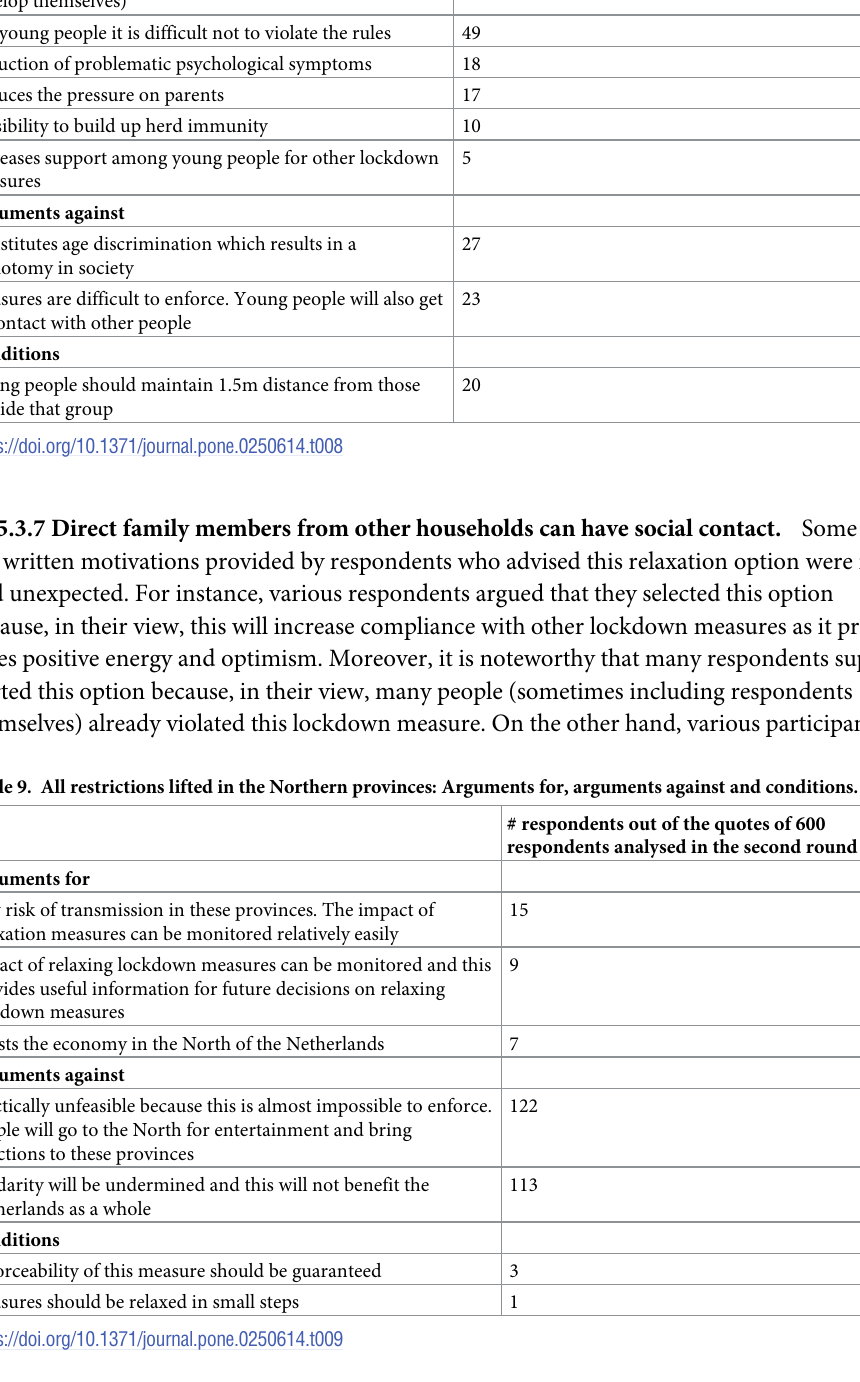
# respondents out of the quotes of 600 respondents analysed in the second round